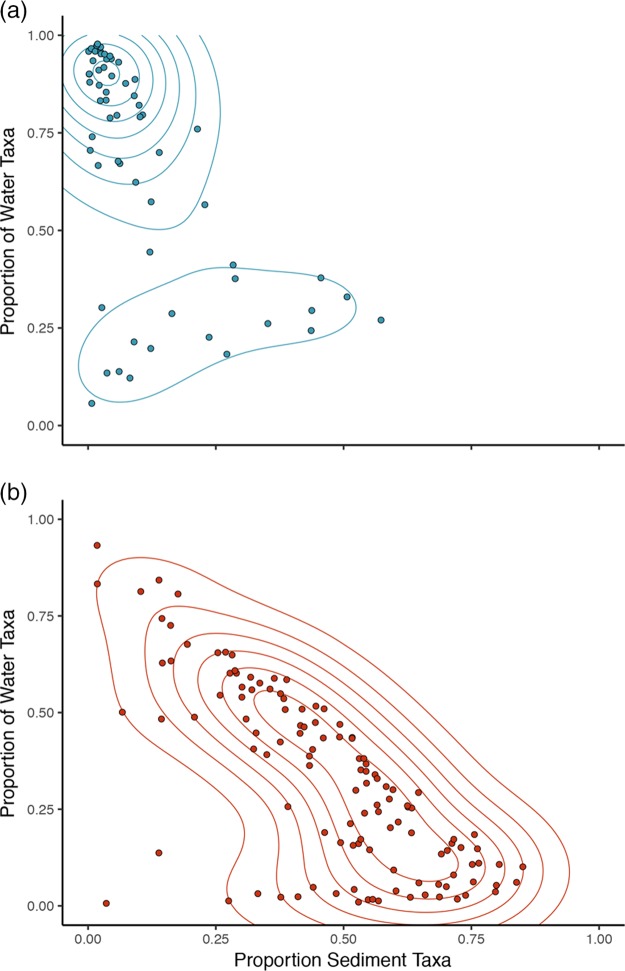
Results of SourceTracker analysis for leaf (a) and root (b) samples, where points represent individual microbial communities. Colors are the same as in Fig. 1: blue, leaves; and red, roots. Contours are drawn according to a 2-dimensional Gaussian kernel used for density estimation and delineate dense clusters of data points.